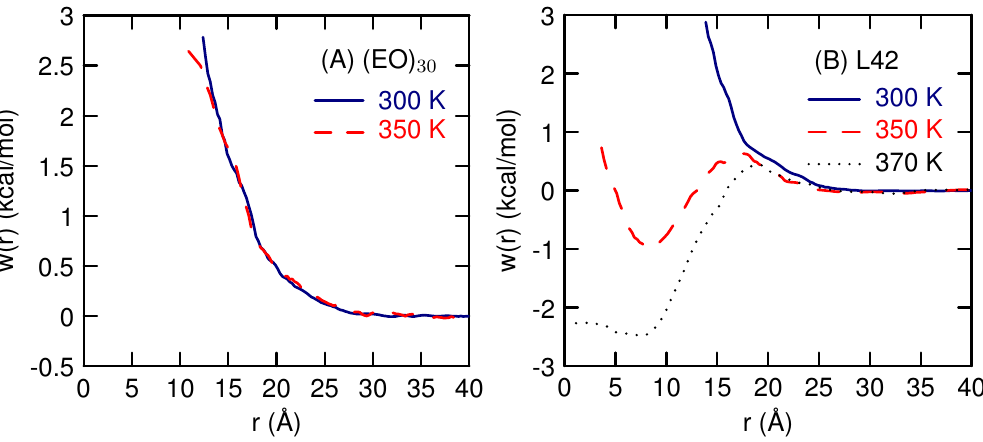
Figure 9. The potential of mean-force between The polymer centers-of-mass at different temperatures for aqueous dimers of ( A ) EO 30 and ( B ) L42.